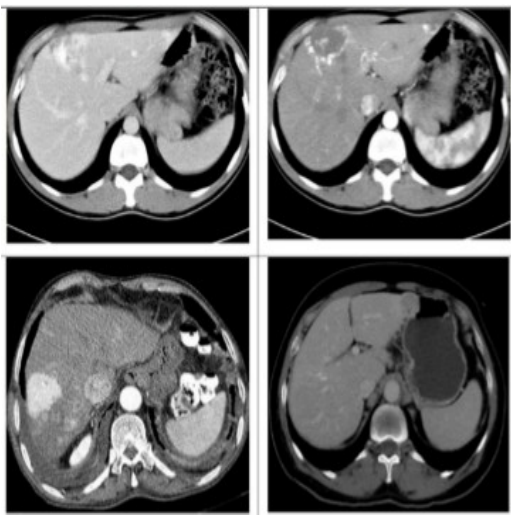
Figure 5. Computed tomography (CT) images of liver lesions.